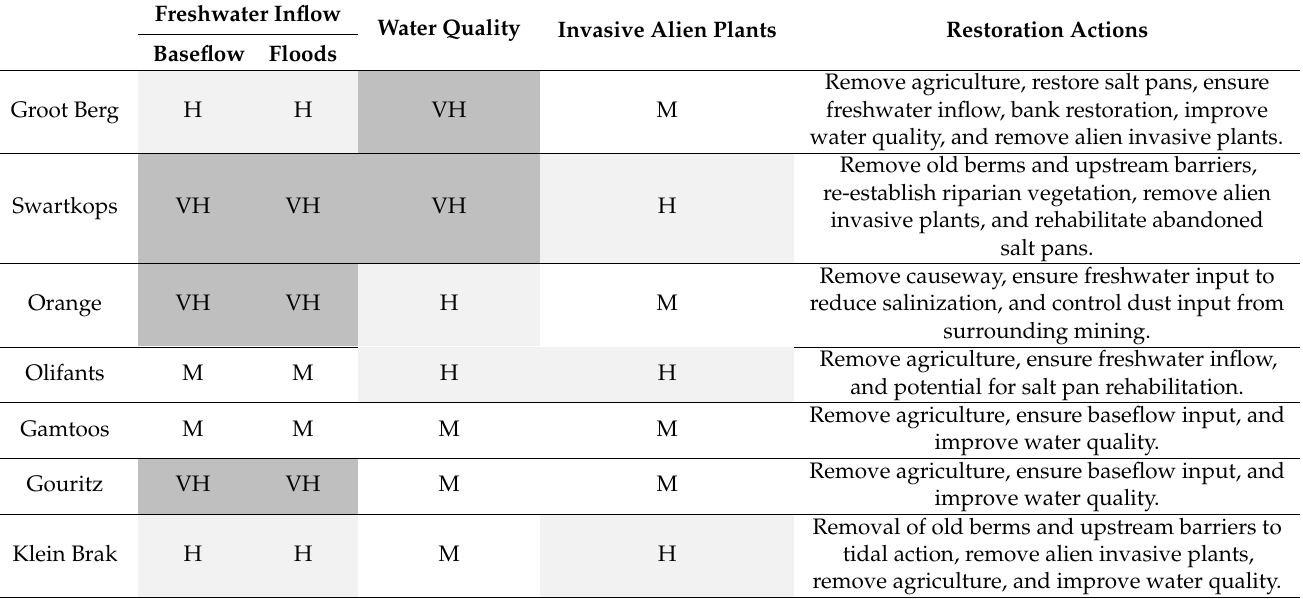
Table 4. Pressures (VH = very high, H = high, and M = medium) that require attention in order to restore salt marsh in seven estuaries that have the largest potential for salt marsh restoration. Specific restoration actions are